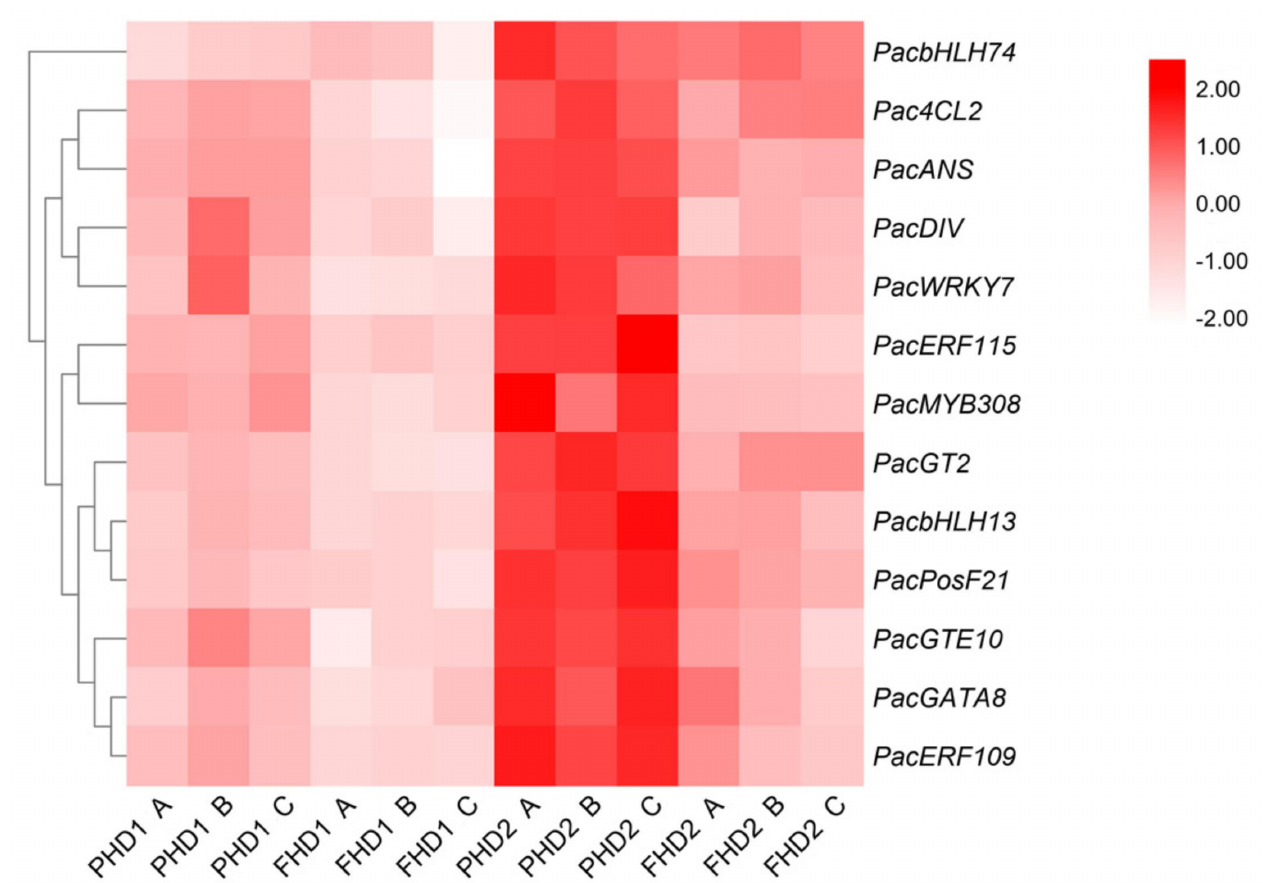
Figure 4. Expression of structural genes and transcription factors (TFs) with putative functions in sweet cherry anthocyanin biosynthesis from RNA − seq. FPKM (fragments per kilobase of exon model per million mapped reads) values were used to draw the heatmap. Transcript abundance is indicated by color − the redder the square, the higher the